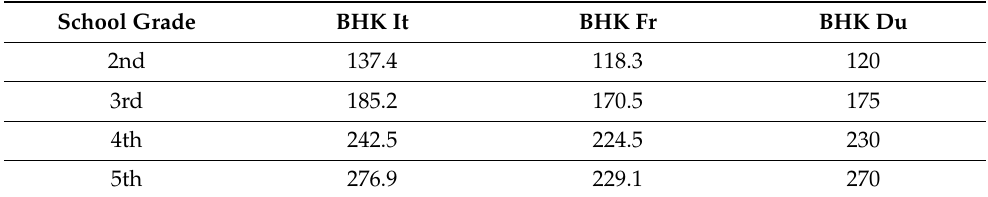
Table 6. Comparison among the speed in three different versions of the BHK (Italian, French, and Dutch) for school